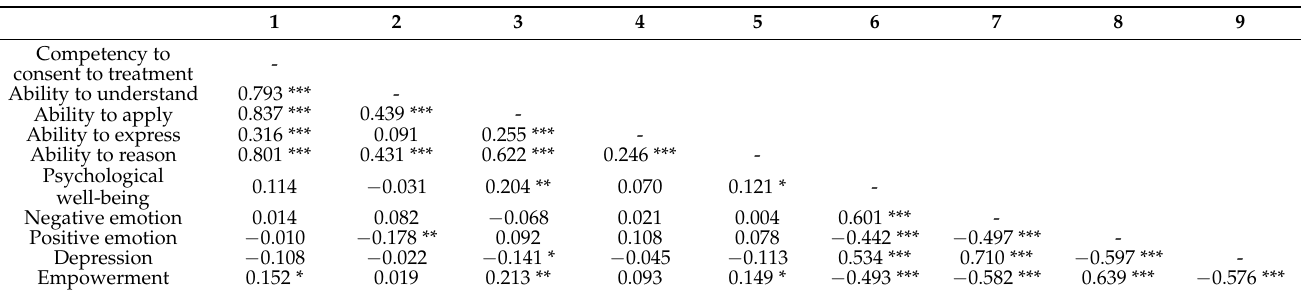
Table 1. Correlation among variables ( n =